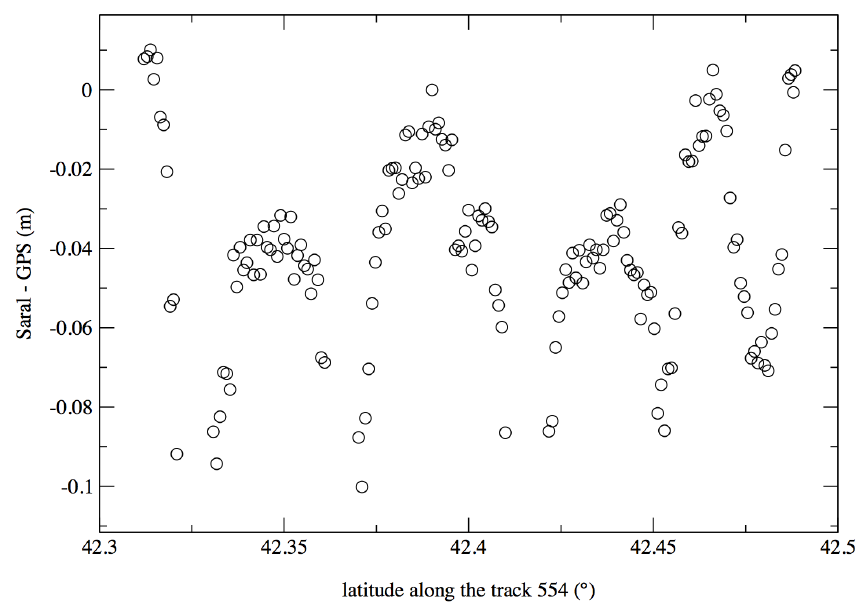
Figure 7. Differences between the GPS profiles and SARAL/AltiKa water altitude above the ellipsoid with ocean retracker at reference points corresponding to the GPS points along the SARAL/AltiKa track